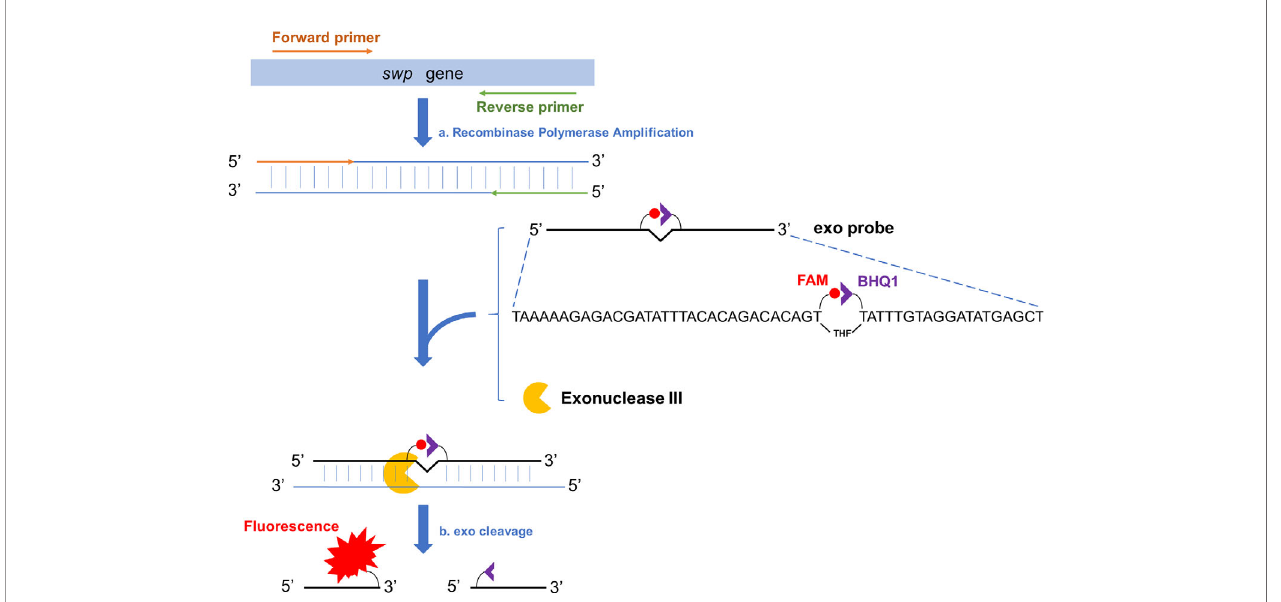
FIGURE 1 | Schematic representation of the real-time RPA assay. Fragment of the target gene ( swp gene in case of EHP detection) is isothermally ampli fi ed by recombinase polymerase ampli fi cation (event a). To one of the ampli fi ed strands, the exo probe anneals, and the Exonuclease III (exo) cleaves at the THF site once the bases fl anking it have paired (event b). On the exo probe, the two T bases adjacent the THF site have been substituted by FAM-dT ( fl uorescent group) and BHQ1-dT (quenching group), respectively. The exo cleavage separates the two groups to allow fl uorescence emission. There is a SpC3 group (not shown in this diagram) at the 3 ’ -end of the exo probe to block the undesired extension of the